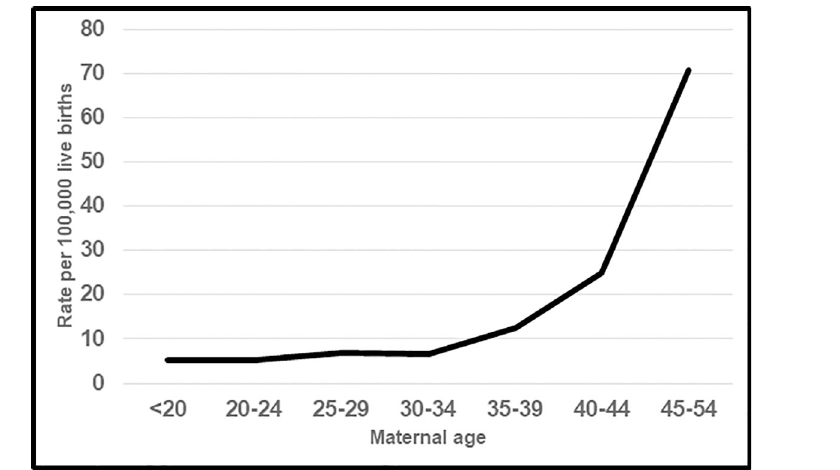
Fig 1. Confirmed maternal mortality rates by maternal age, United States, 2016–2017. https://doi.org/10.1371/journal.pone.0253920.g001 the rates were significantly different at the p < .05 level. The study was ruled exempt from IRB review by the University of Maryland IRB as the study was based on death certificates and there were no living human subjects.